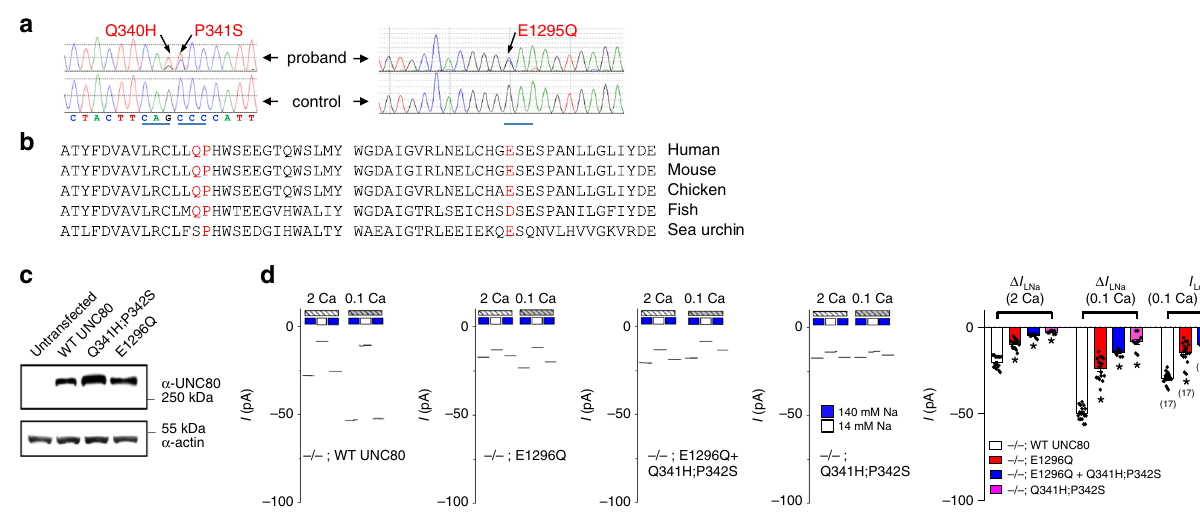
Fig. 3 Haploinsuf fi cient reduction in UNC80 is associated with severe intellectual disability. a Sanger sequencing chromatograms con fi rming the whole- exome sequence fi ndings of genetic variations in the proband leading to protein changes of Q340H, P341S (left), and E1295Q (right). Upper: from the proband; lower: control. Codons encoding Q340 (CAG), P341 (CCC) and E1295 (GAA) are underlined. b Protein sequence alignments showing conservation in the Q340, P341 (left) and E1295 (right) regions. Accession numbers of the sequences used are NM_032504 (human), NP_780719